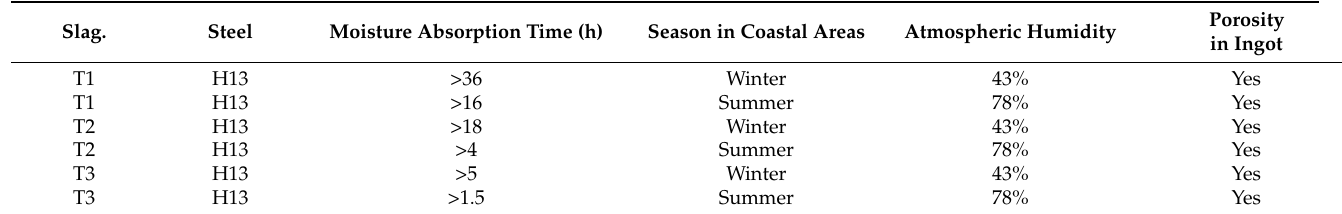
Table 6. Prediction of porosity defects in ingots analyzed by machine learning methods.